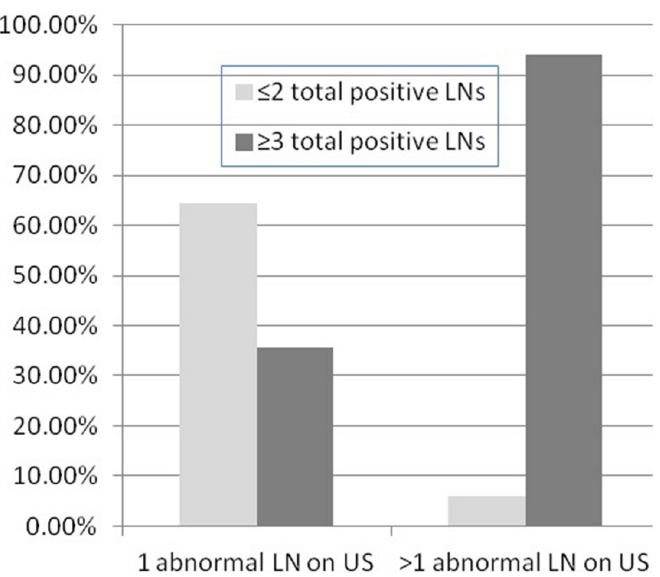
Fig 2. Positive lymph node (LN) involvement for women with 1 or > 1 abnormal axillary LN identified by ultrasound (US).